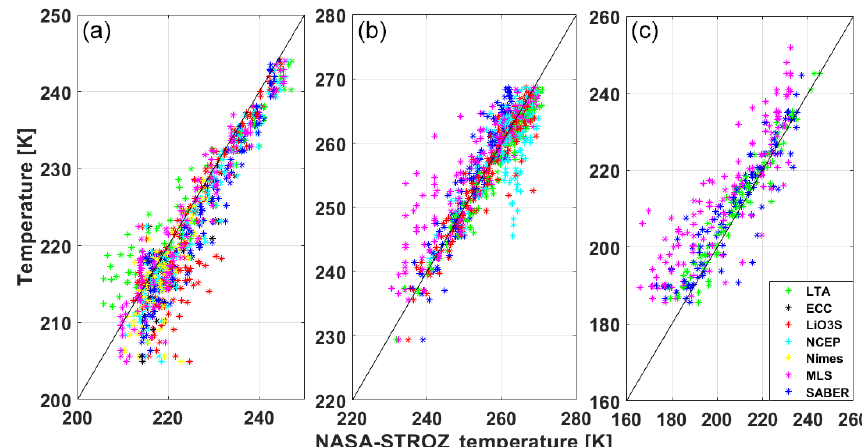
Figure 16. Scatter plots of temperature as measured by the various LAVANDE instruments (along the vertical axis) and temperature measured by NASA STROZ (along the horizontal axis). (a) Temperature from 12 to 35km altitude. (b) Temperature from 35 to 60km altitude. (c) Temperature from 60 to 80km altitude.